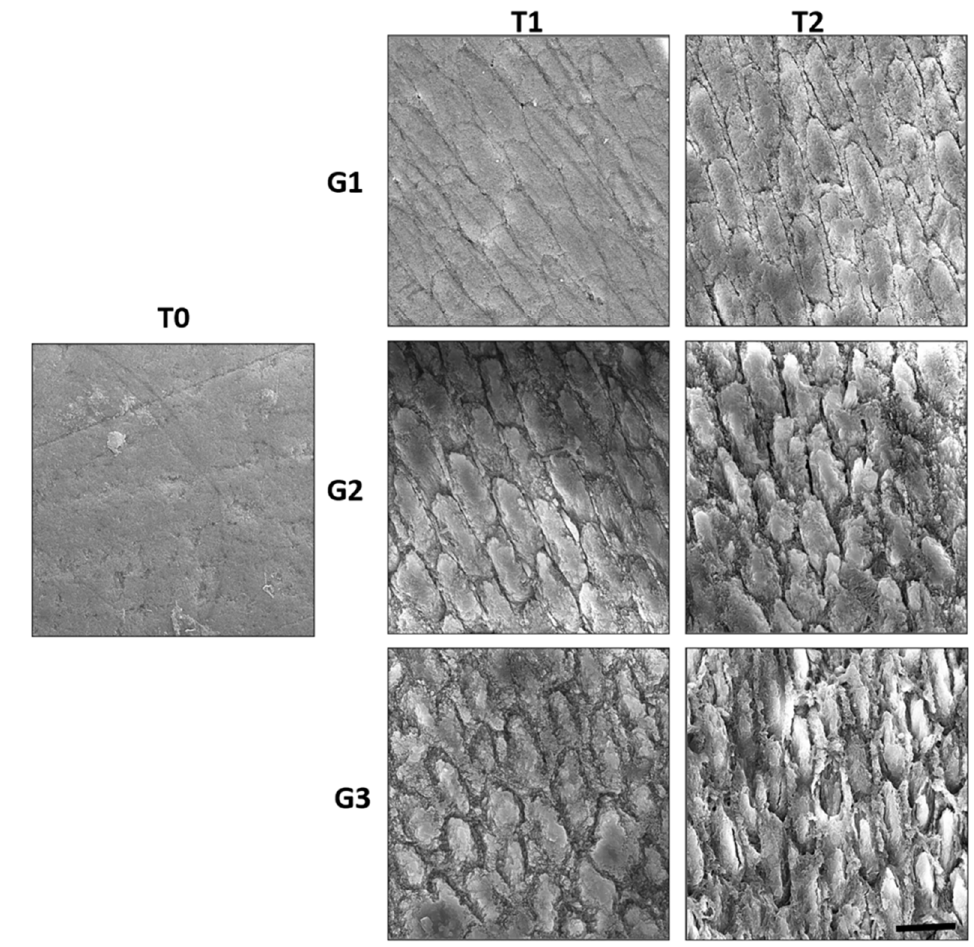
Figure 5. The scanning electron microscopy images representative of the effect of the following treatments with time on dental enamel: T0 without treatment (artificial saliva), G1-T1 CP22 for 14 days, G2-T1 CP22 + Gatorade for 14 days, G3-T1 CP22 + Gatorade + simulated toothbrushing for 14 days. T2 images following the same treatments for 28 days. Scale Bar: 5 µm. CP22, 22% carbamide peroxide.